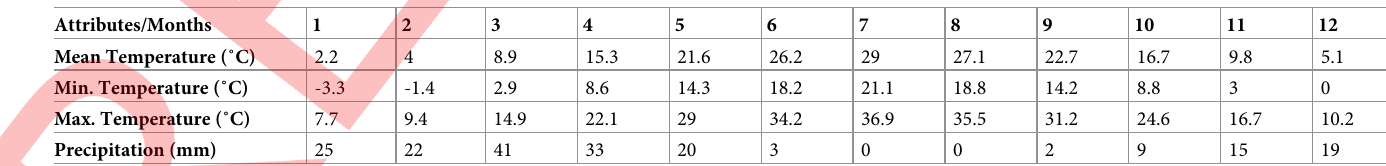
Table 1. Average long-term climate data of the Dushak city, Turkmenistan.